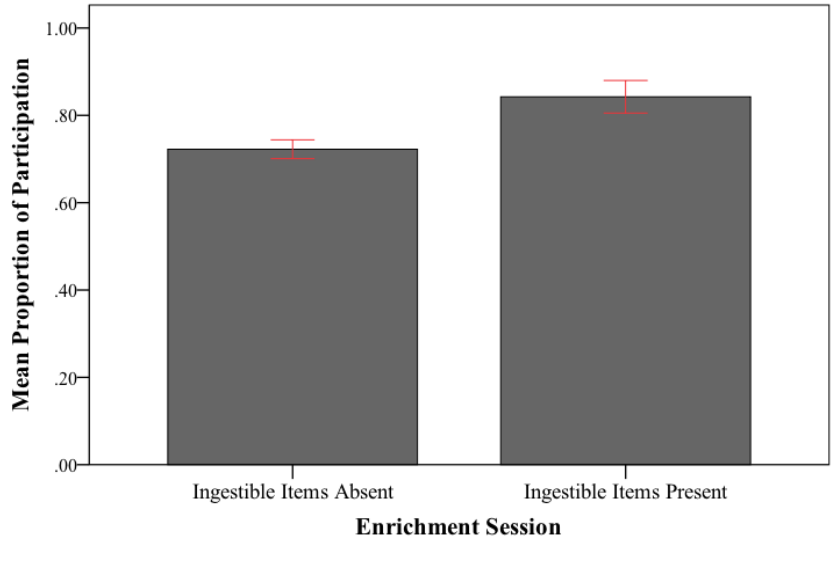
Figure 3 . Mean (±2 SE) proportion of subjects ( n = 19) that participated with ingestible enrichment classes versus non-ingestible classes, including all trials and subjects ( p <